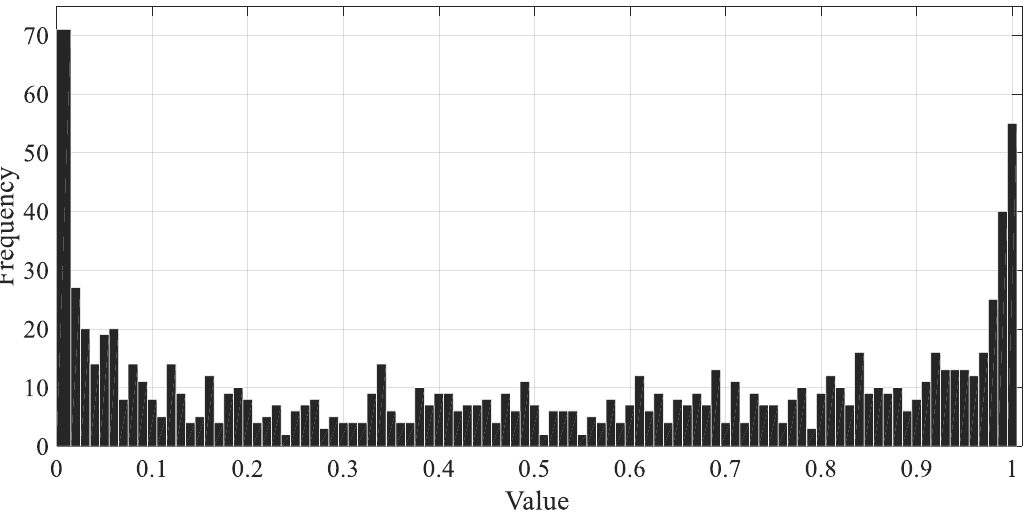
Figure 3. Histogram of generated weights ( ρ Chebyshev ) from the Chebyshev map over 1000 iterations.